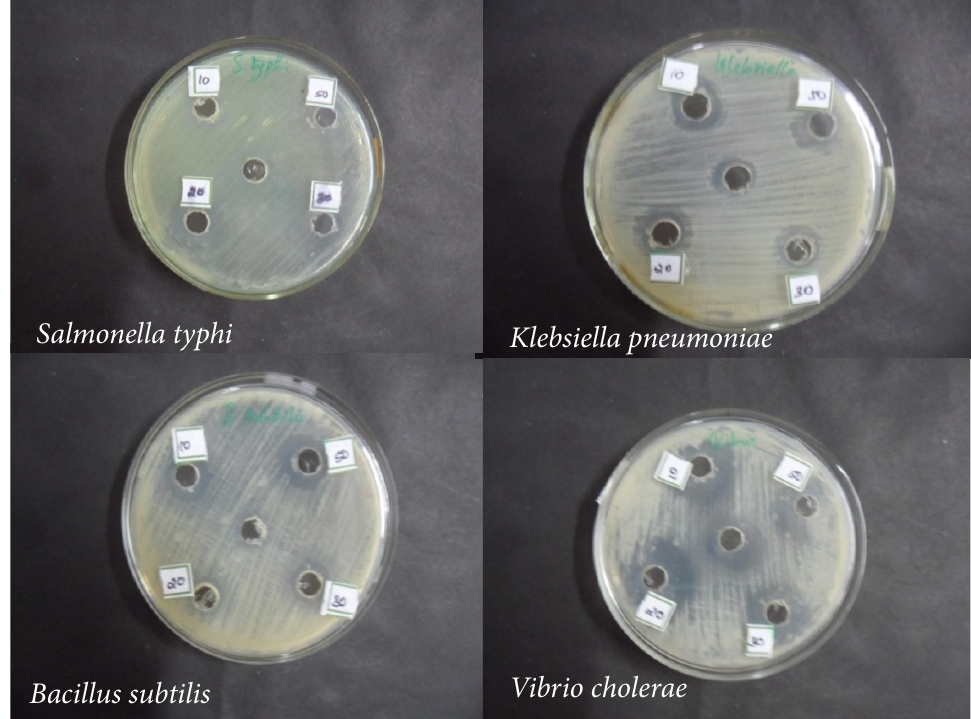
Bacillus subtilis Fig. 7. Antimicrobial activity of silver nanoparticle synthesised by supernatent of Escherichia coli